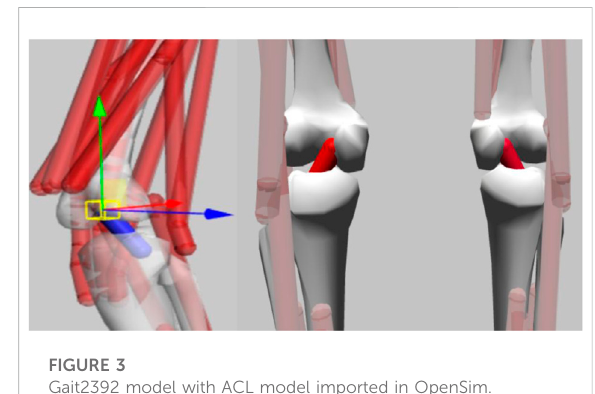
Gait2392 model with ACL model imported in